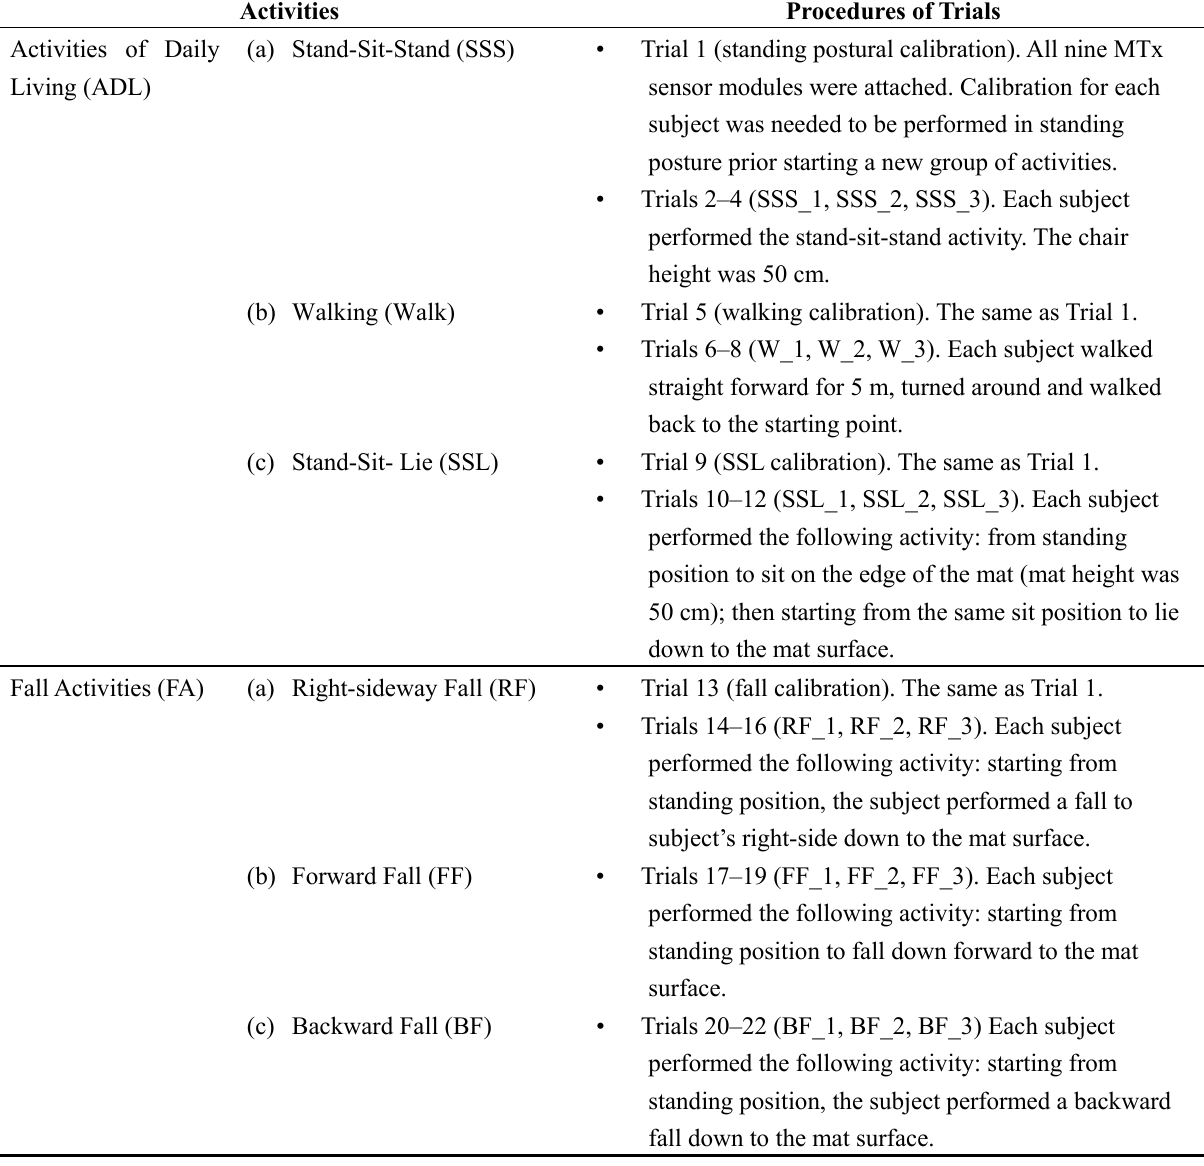
Table 1. Experimental procedures used for ADL and FA for each subject in this